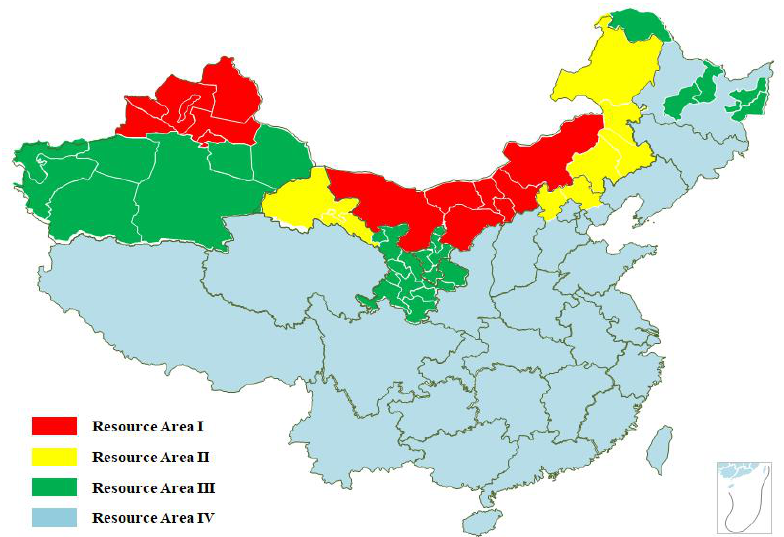
Figure 1. Distribution map of China’s 4 types of onshore wind energy resources.